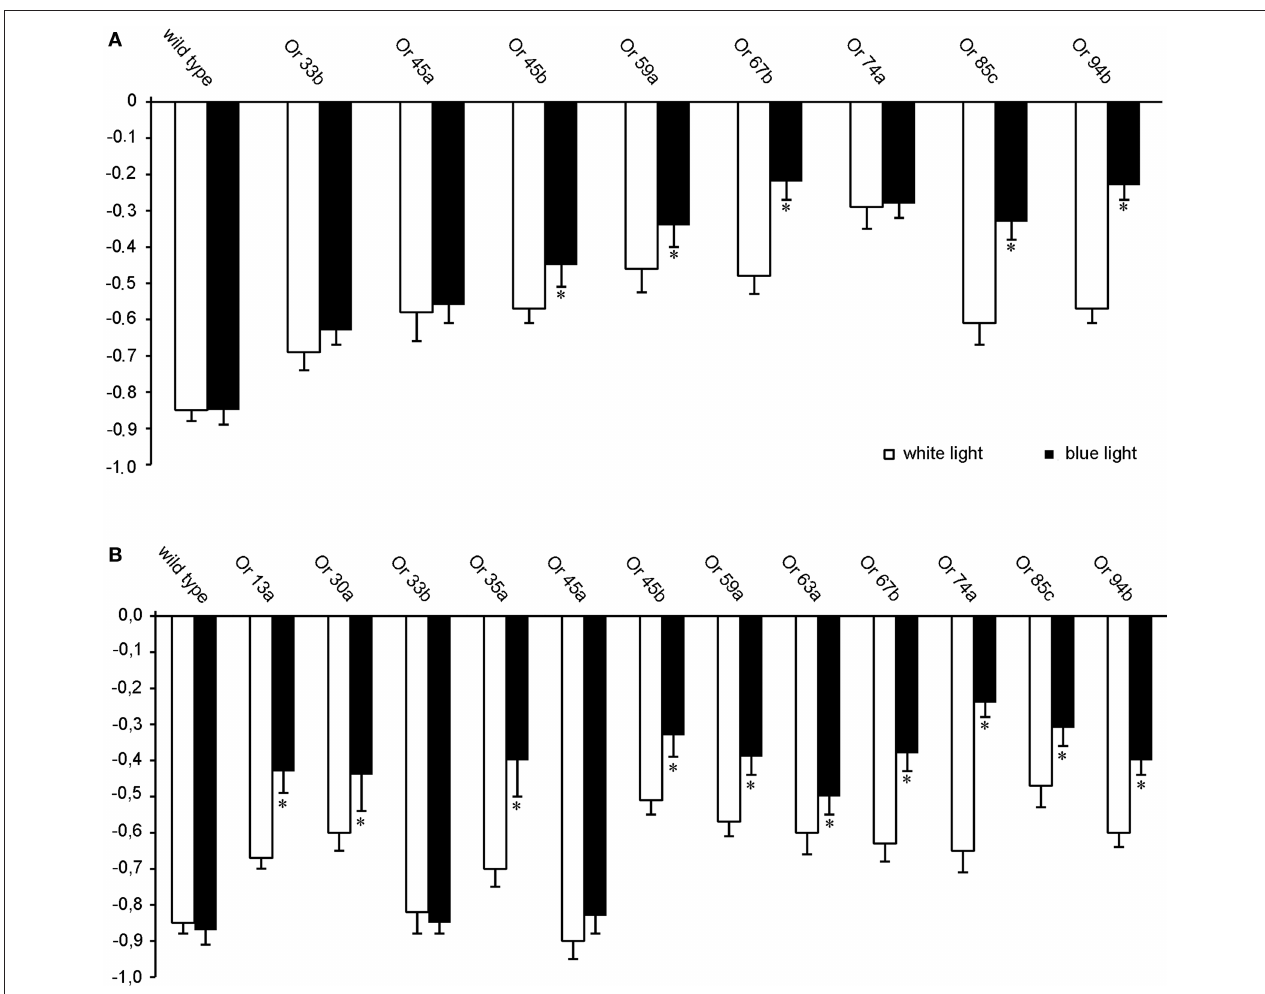
Figure 4 | Orientation behavior of transgenic larvae in the four quadrant assay with two quadrants illuminated either with blue or white light, showing the photo-activation of individual OrNs ( n = 20). Expression of